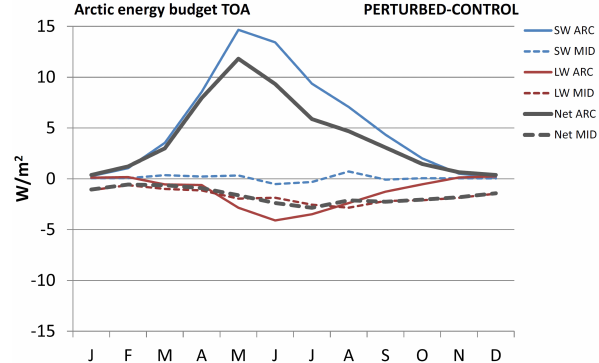
Fig. 12. Changes in the Arctic monthly mean radiative fluxes TOA; incoming SW (blue), outgoing LW (red) and net (black) for the ARC-CONTROL (solid) and MID-CONTROL (dashed). All units in Wm − 2